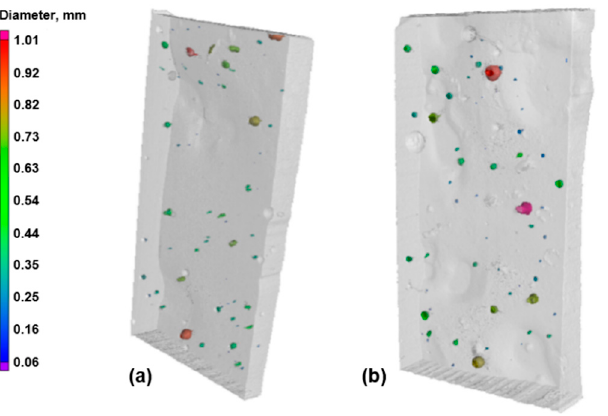
Figure 7. Three-dimensional morphology of bubbles inside the steel sample using ICT: ( a ) sample 1; ( b ) sample 2.